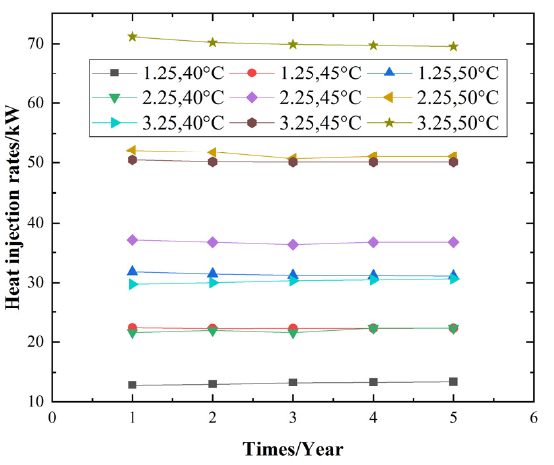
Figure 15. Heat injection rates of the novel DBHE system under different thermal conductivities.